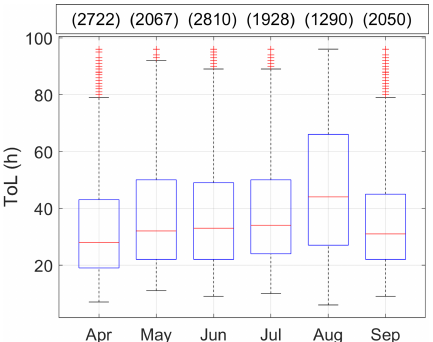
Figure 2. Monthly (growing season) distribution of ToL in air masses arriving from the clean sector in 2006–2016. The red bars show the median of the observations, while the top and the bottom of the boxes indicate the 75th and 25th percentiles. The whiskers mark the furthest observations that are not classified as outliers, which are indicated with the red crosses and are more than 1.5 times the interquartile range away from the box limits. The number of clean-sector trajectories in each month in the 11 years is shown in the text box